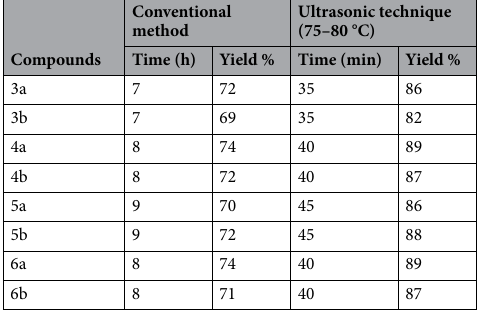
Table 2. Experimental conditions for compounds (3–6) by conventional and ultrasonic